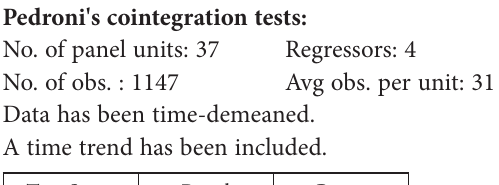
Table B.3. Cointegration test results for non-high income countries